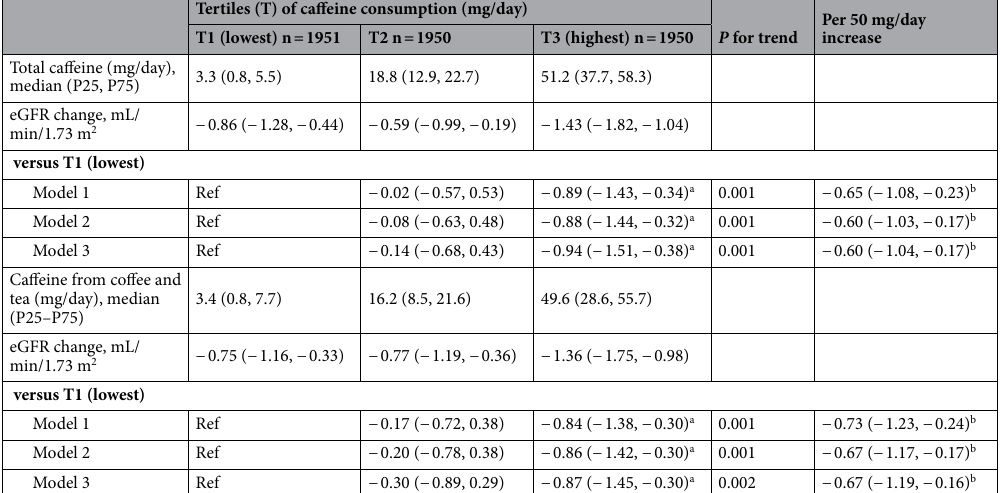
Table 4. Crude and multivariate linear regression models of 1-year changes in eGFR according to tertiles of caffeine intake at baseline. Values are means (95% CI) unless otherwise indicated. eGFR estimated glomerular filtration rate, Ref. referent value. P value for trend based on multivariate linear regression treating the median values of each category as an ordinal variable. Model 1: adjusted for sex (men or women), age (years, continuous), and baseline eGFR (mL/min/1.73 m 2 , continuous). Model 2: additionally adjusted for BMI (kg/m 2 , continuous), smoking (never, current, or former smoker), educational level (primary, secondary education or academic/graduate), physical activity (MET-min/day, continuous), type 2 diabetes prevalence (yes or no), dyslipidemia (yes or no), hypertension (yes or no), center (four categories by number of recruited participants: < 200, 200–250, 250–300, or ≥ 300), intervention group (intervention or control group), MedDiet score (17-points, continuous) and total energy intake (kcal/day, quartiles). Model 3: additionally adjusted for dietary intakes of total protein, saturated fat, alcohol, fiber, sodium, magnesium, potassium (each categorized at energy-adjusted quartiles), 1-year changes in systolic blood pressure (mm Hg, continuous), and 1-year changes in body weight (kg, continuous). All analyses were conducted with robust estimates of the variance to correct for intra-cluster correlation. a P < 0.05 (compared to the reference group). b P < 0.05. Total caffeine consumption was computed from FFQs taking into account the caffeine contained in caffeinated coffee, decaffeinated coffee, tea, regular sodas, artificially sweetened soda, and